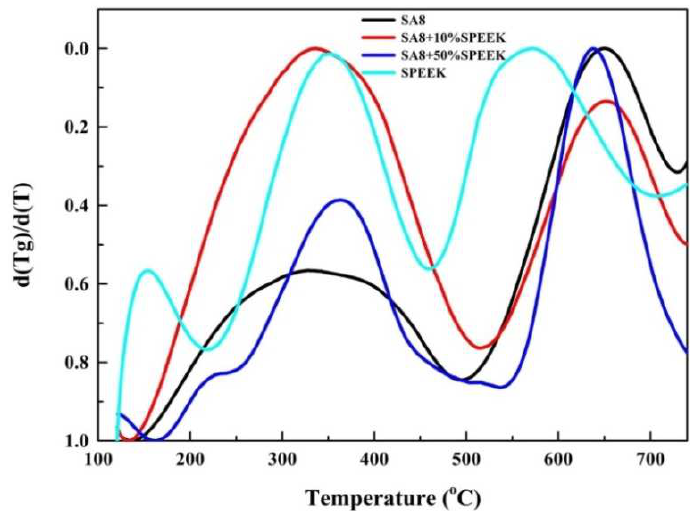
Figure 14. DTG diagram of SA8 polymer blended with sPEEK.